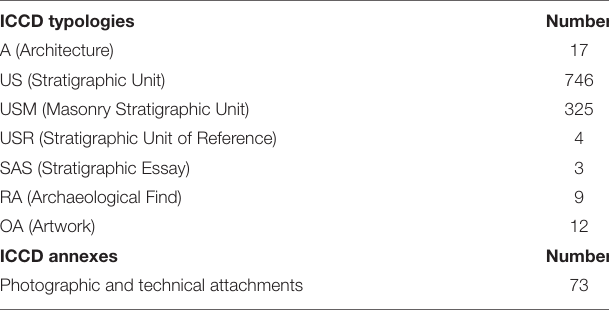
TABLE 4 | Representation of the ICCD cards belonging to the “Castel Nuovo”